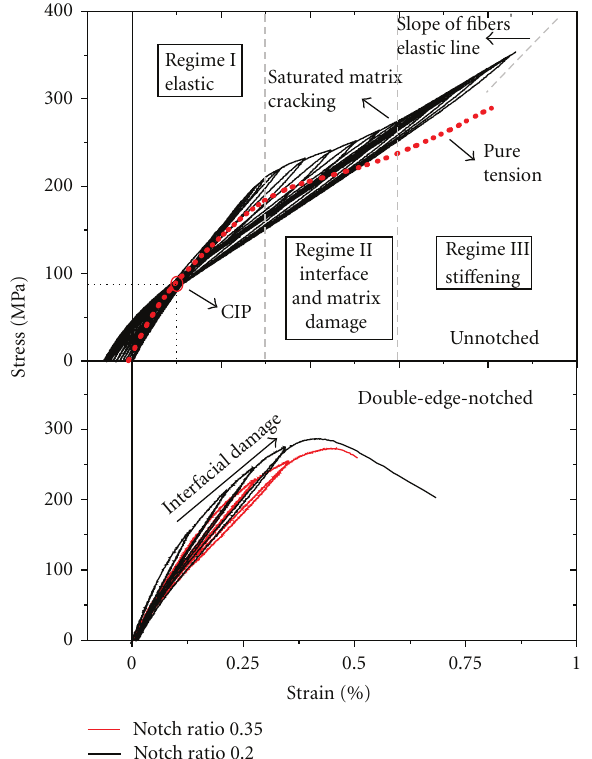
F 2: Typical mechanical response of the SiC/BMAS composite in tension for various initial notches.